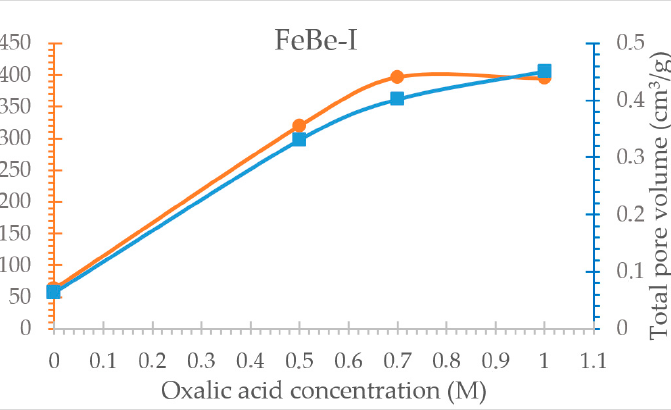
Figure 8. Specific surface area and total pore volume diagram of raw (labelled as “0” in the horizon- tal axis) and treated FeBe-I samples (80 °C; acid concentrations of 0.5 M, 0.7 M and 1 M; 2% of pulp density).